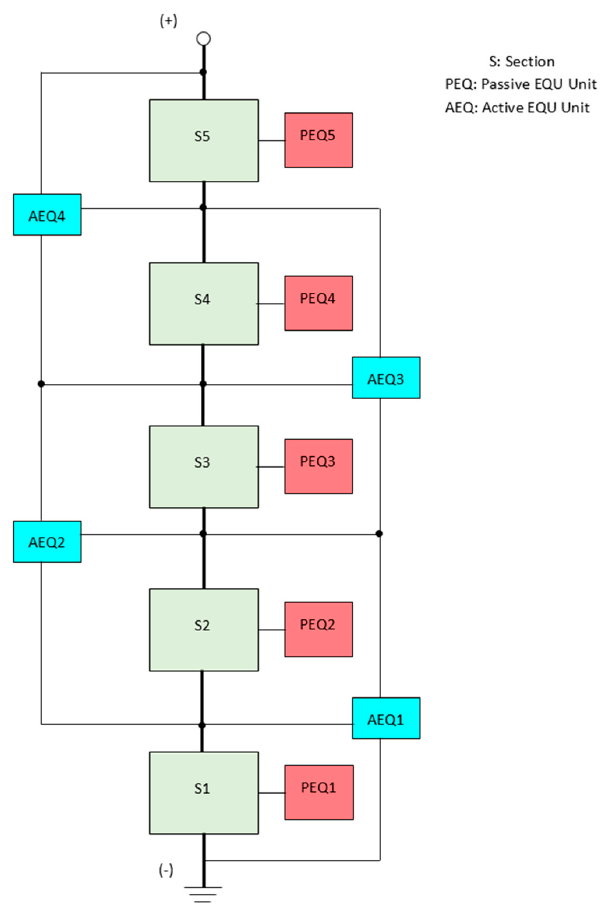
Figure 3. Bilevel equalizer (BEQ) for a battery pack with 5 sections.